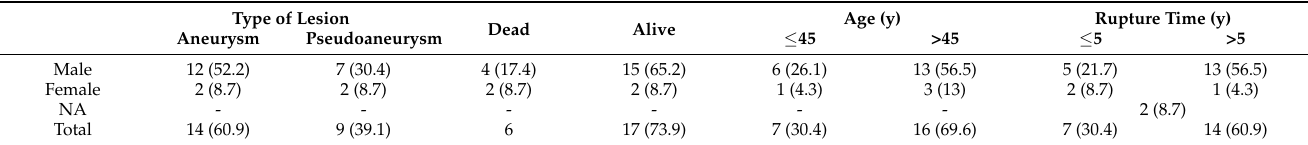
Table 2. Provides a summary of the main information that can be gleaned from Table 1. Individuals were divided according to sex, age, studying their time to rupture, and outcome. The percentage was calculated based on the total number of cases (23).